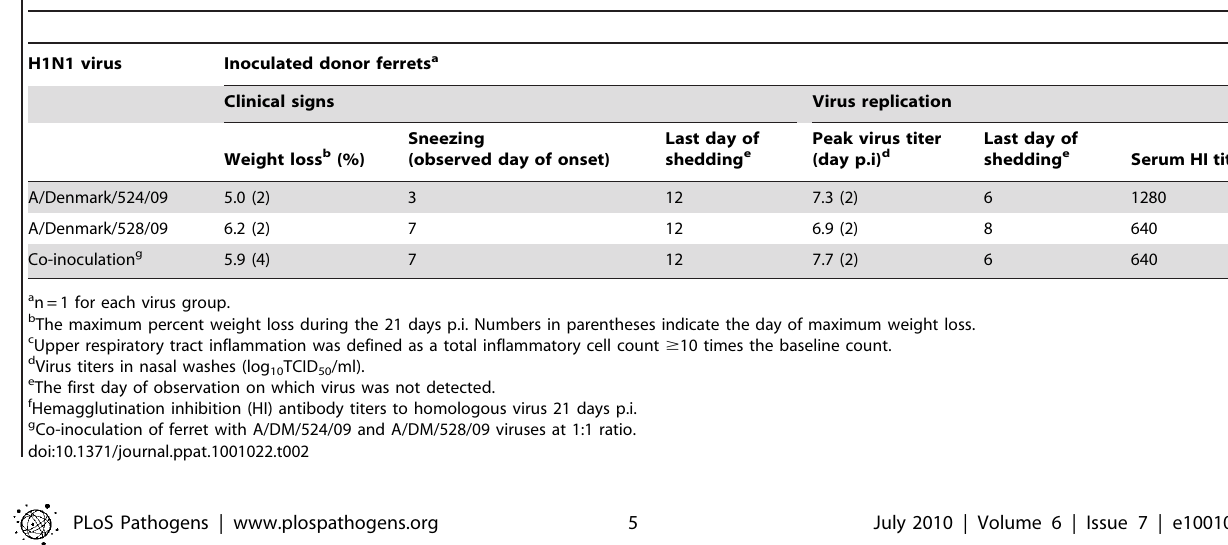
Table 2. Clinical signs, virus replication, and seroconversion in inoculated donor ferrets.